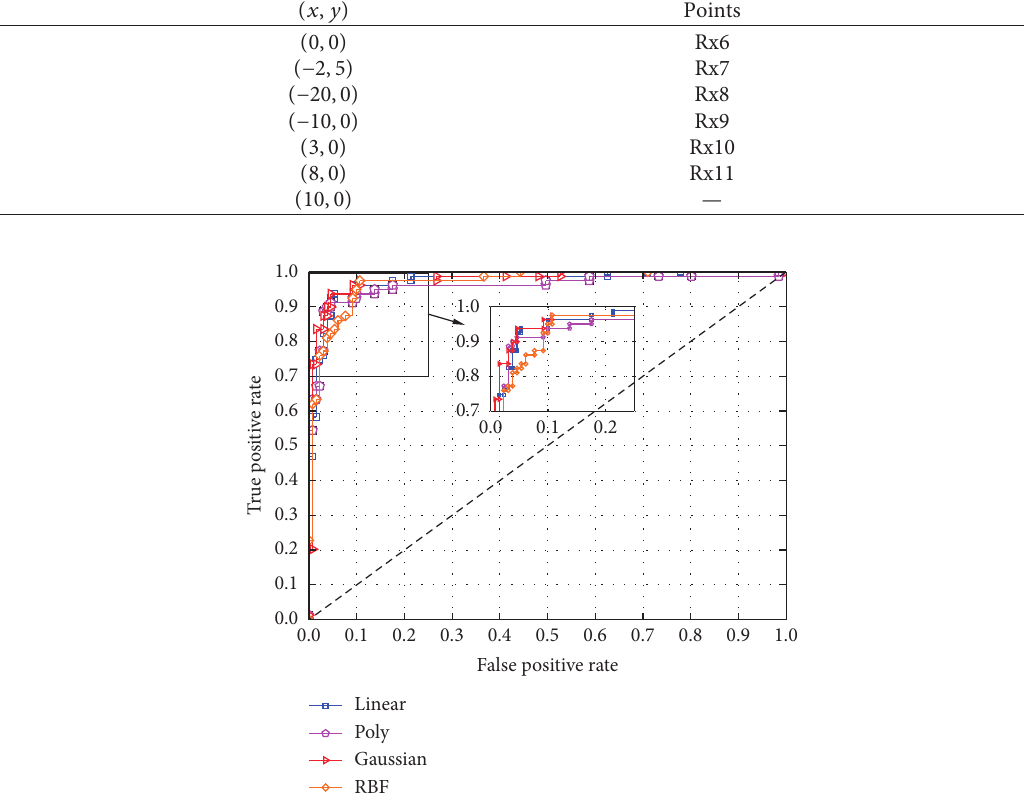
Figure 4: ROC of four kernel functions on identification. Table 3: AUC values of four kernel functions.